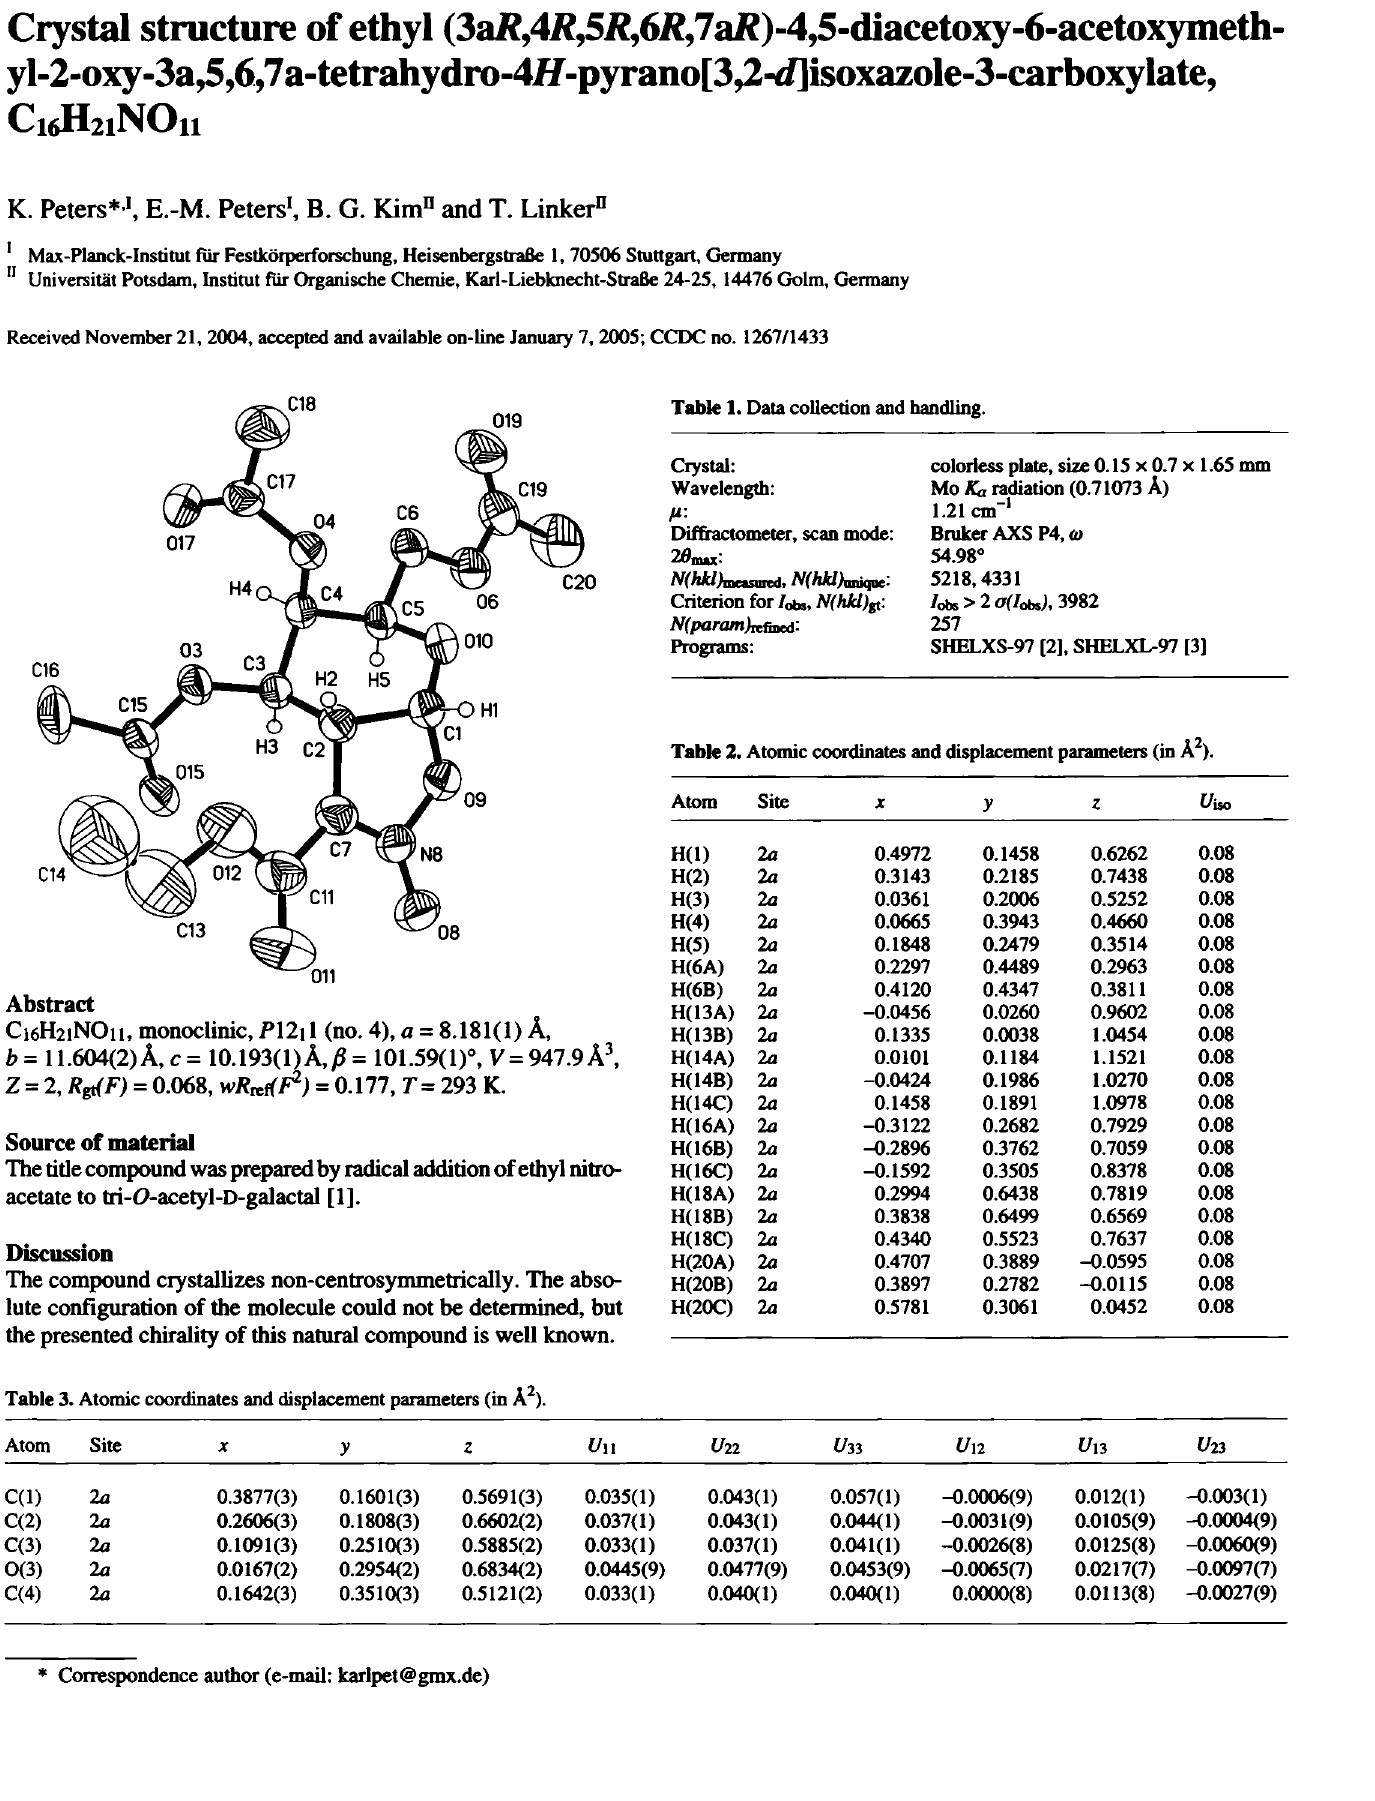
Table 3. Atomic coordinates and displacement parameters (in A 2